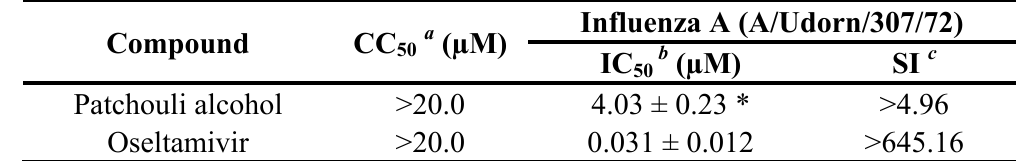
Table 1. Anti-influenza A (H2N2) virus activity of patchouli alcohol compared with